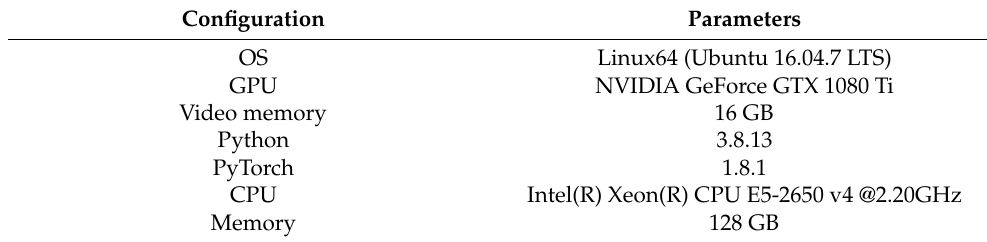
Table 2. Experimental Environment